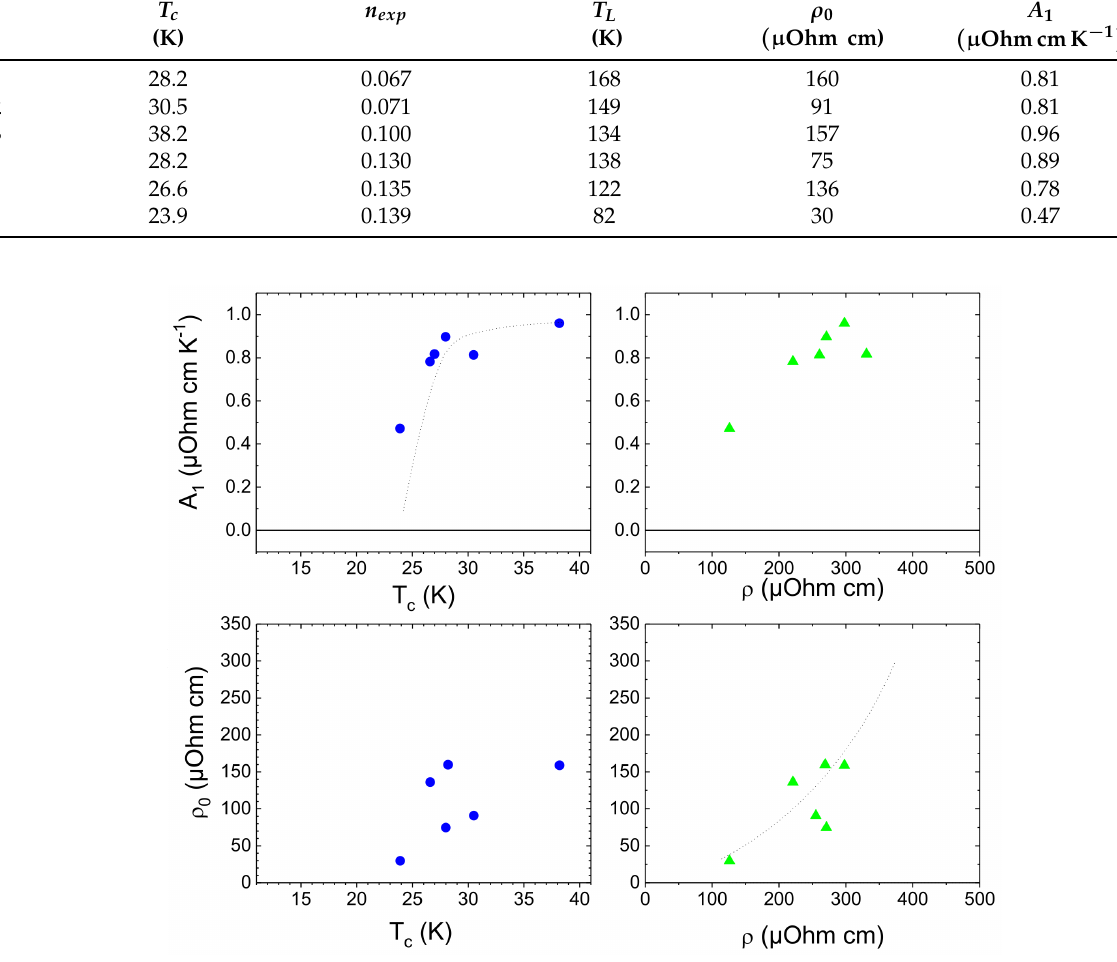
Figure 4. (Color online) Best-fit parameters A 1 and ρ 0 (upper and lower panels, respectively) as a function of the superconducting temperature T c (blue dots) and the room temperature resistivity ρ (green triangles), respectively. Lines are guides for